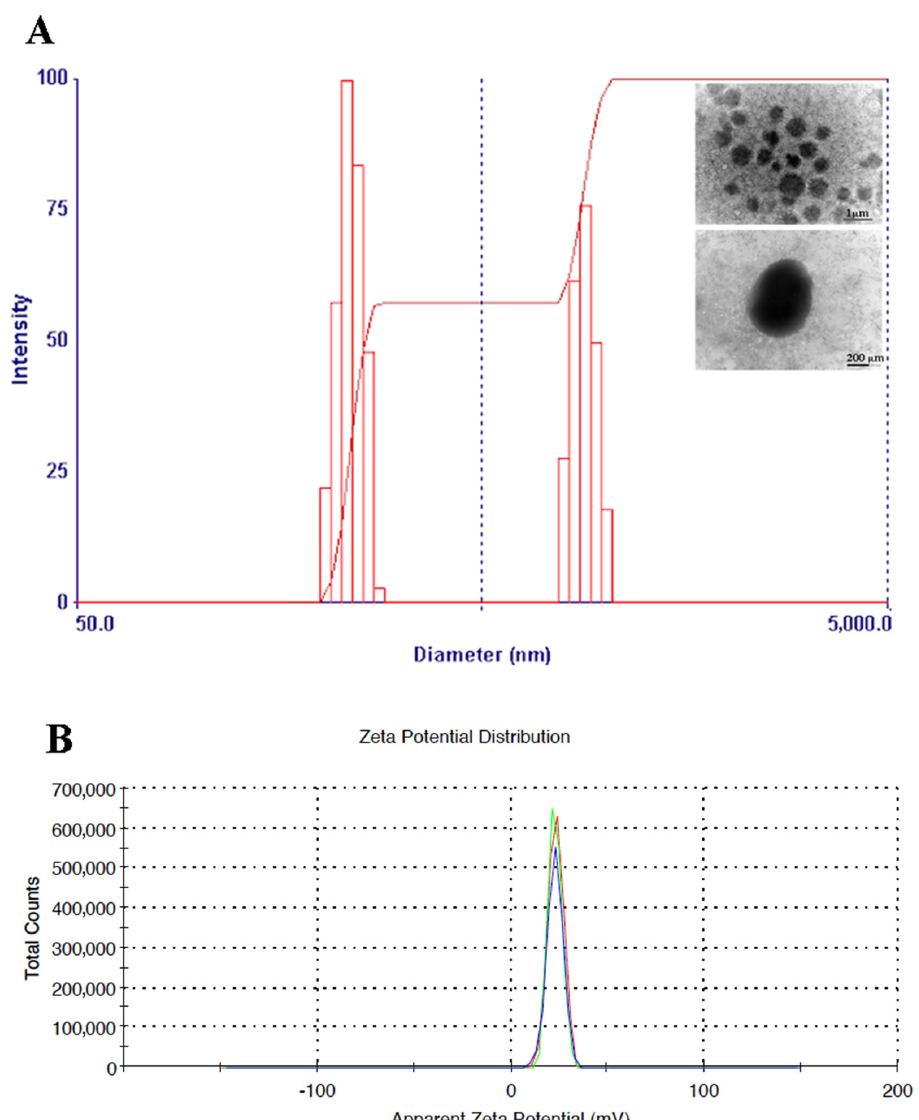
Figure 2. Physicochemical characterization of OLE-loaded CTNPs: ( A ) Particle size distribution by the DLS analysis and TEM micrographs; ( B ) Zeta potential distribution.